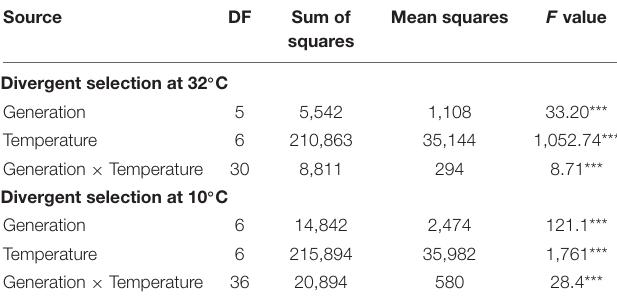
TABLE 2 | Two-way ANOVA of the germination percentage used to evaluate the effect of divergent selection at 32 and 10 ◦ C. Source DF Sum of Mean squares F squares